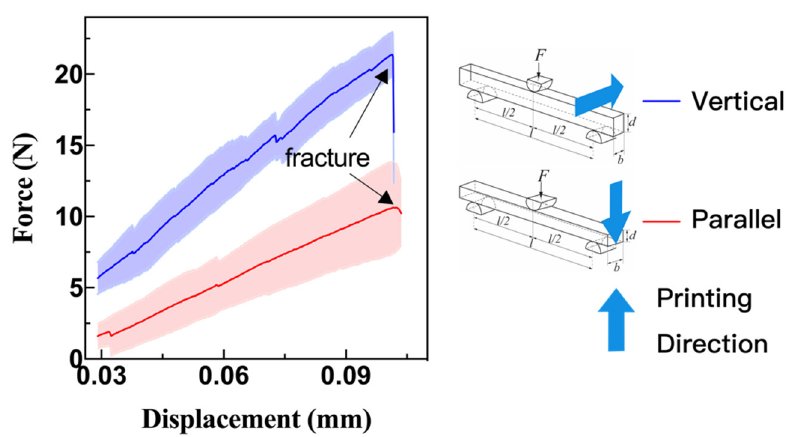
Figure 7. The flexural strength curves.